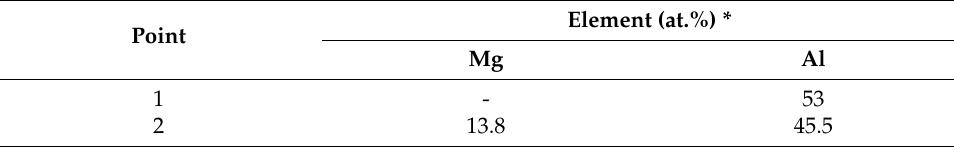
Table 5. EDS analysis of micro-areas indicated in Figure 8.